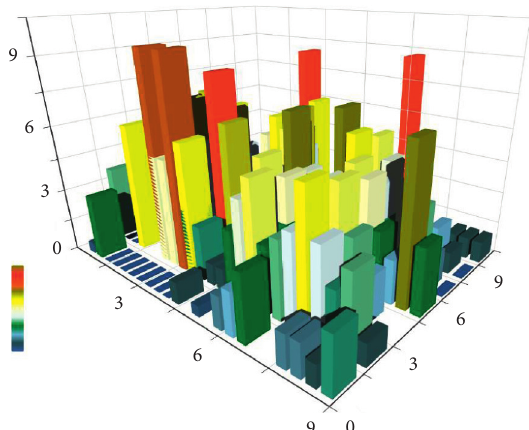
Figure 6: The conclusion expression of logistic regression analysis model 2.